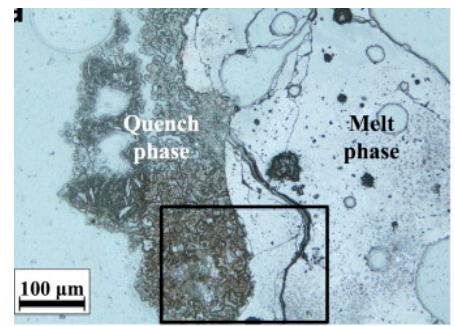
Figure 4. Photomicrographs of bottom ash particle differentiating the melt phase and quench phase [35].